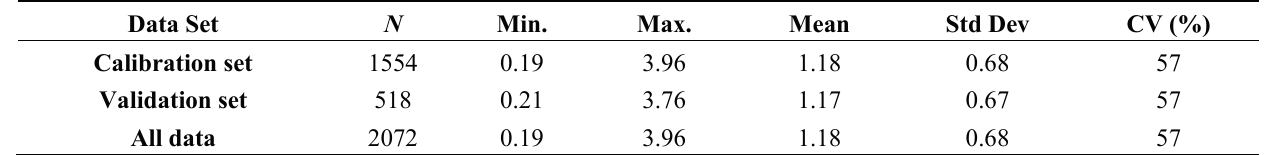
Table 2. Statistics of total nitrogen concentrations (g·kg − 1 ) for the calibration and validation datasets.